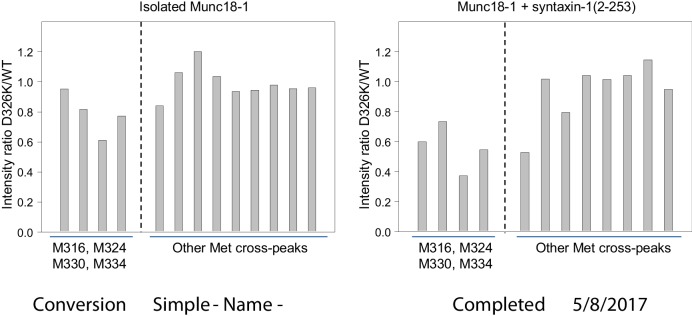
The D326K mutation causes selective decreases in the intensities of the 1H-13C HMQC cross-peaks of methionines from the domain 3a loop of Munc18-1.The plots show the ratios between the intensities of methionine cross-peaks observed for D326K 50%-2H-ILMV-13CH3-Munc18-1 and those observed for WT 50%-2H-ILMV-13CH3-Munc18-1 in the absence (left panel) and presence (right panel) of syntaxin-1 (2–253). The data for the cross-peaks assigned to the four methionines from the domain 3a loop are grouped on the left of each plot, while those for other well-resolved (unassigned) cross-peaks are grouped on the right. To account for small differences in protein concentrations, all intensities in each spectrum were normalized with the average intensity of the unassigned cross-peaks.